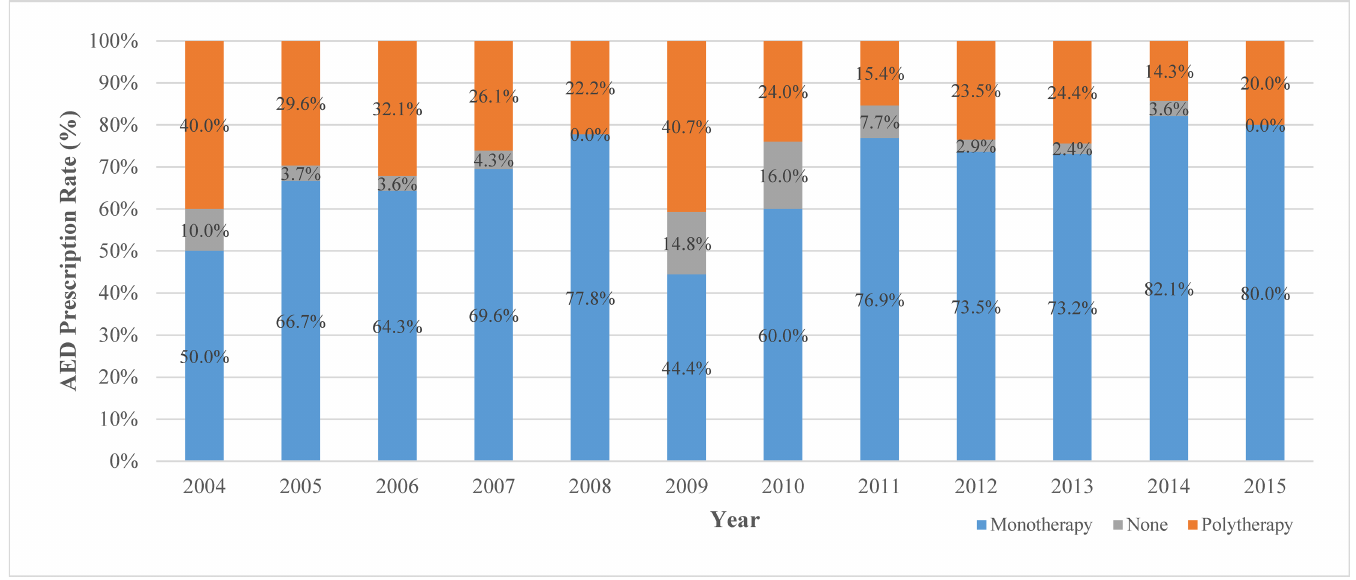
Fig 1. AED monotherapy, polytherapy, and no prescription rates among TREP WWE pregnancies (n = 318).